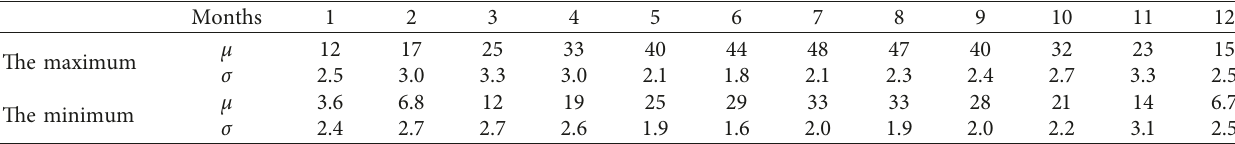
Table 1: The estimated values of the normal distribution parameters of the daily extreme values of the axial uniform temperature in different months.